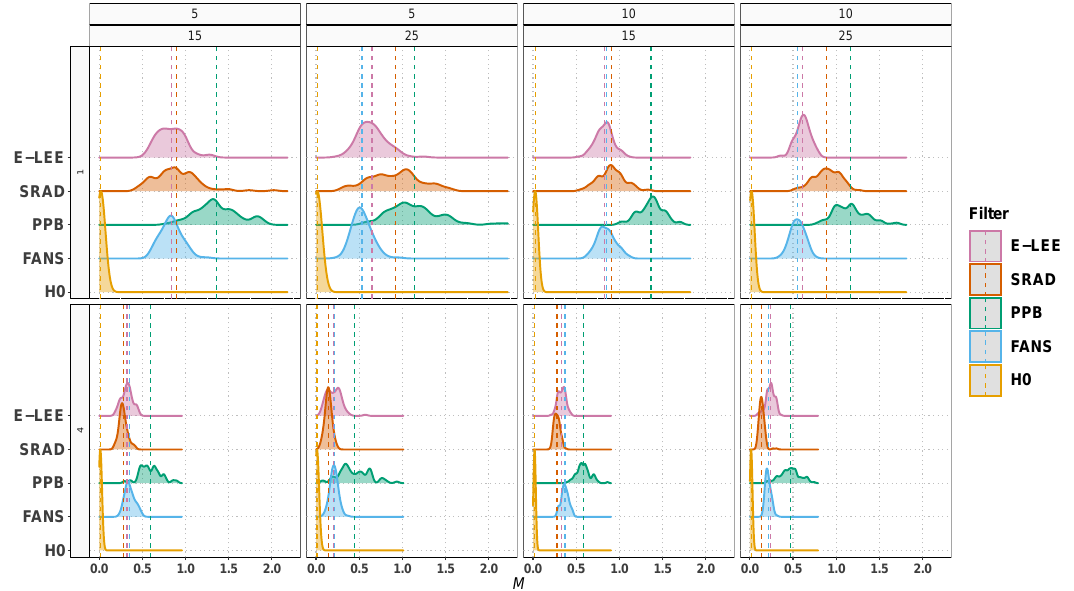
when the filters are applied to the step image. The M under . M H 0